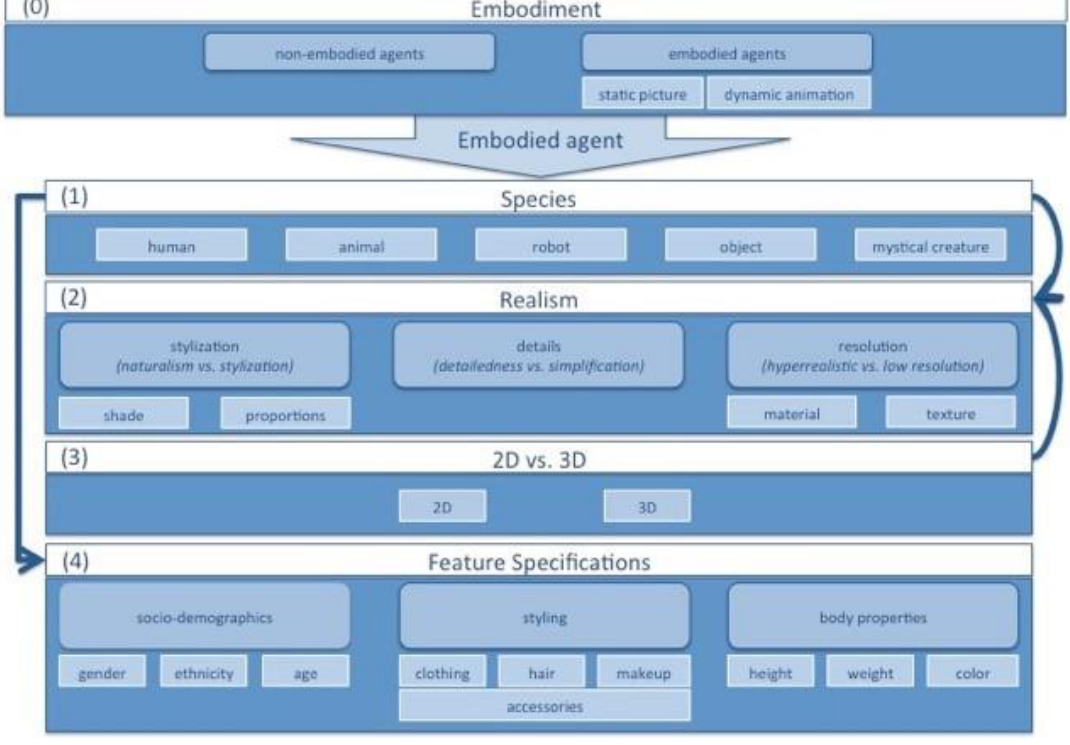
Figure 1. Categorization of different appearance variables. (Reproduced from Straßmann and Krämer [9]).